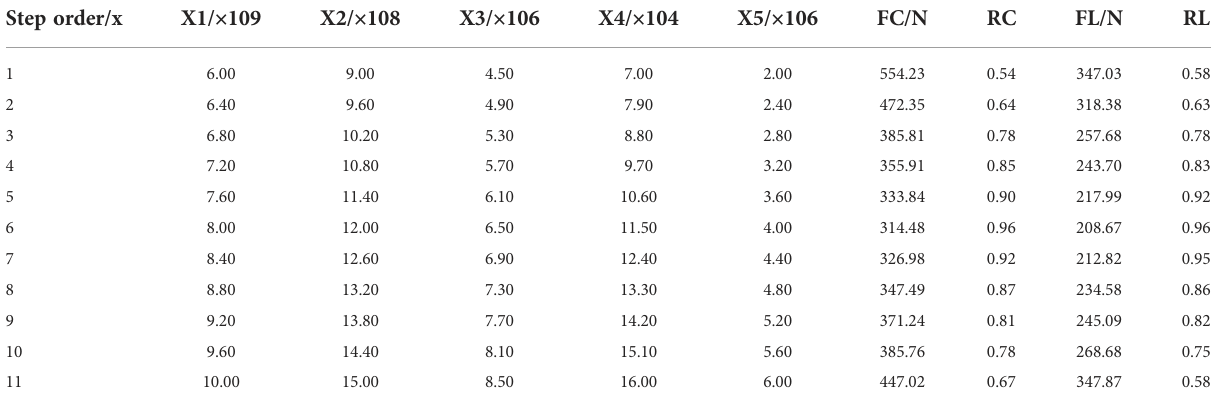
TABLE 5 Calibration experiment